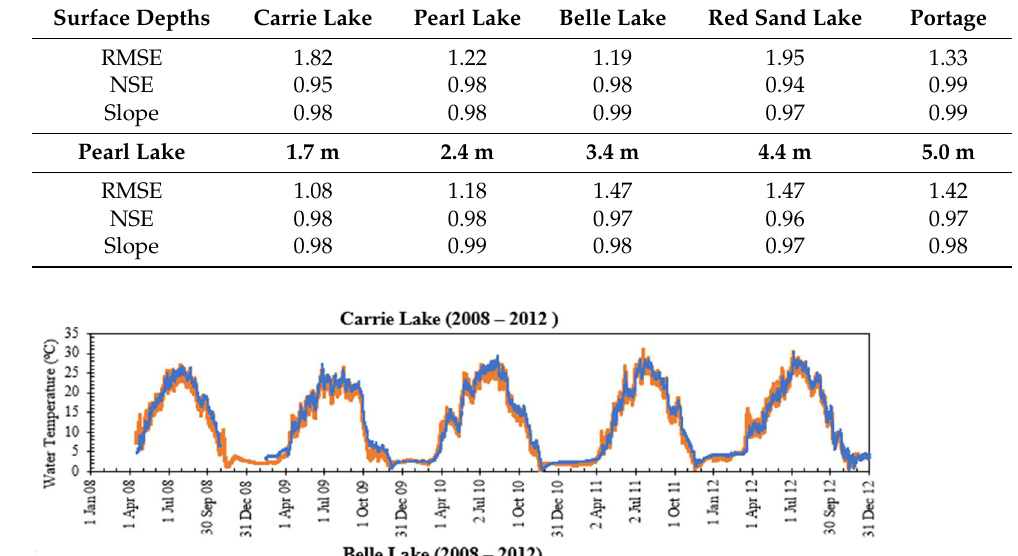
Table 5. Statistical error parameters for the hourly MINLAKE model against observed time-series data.